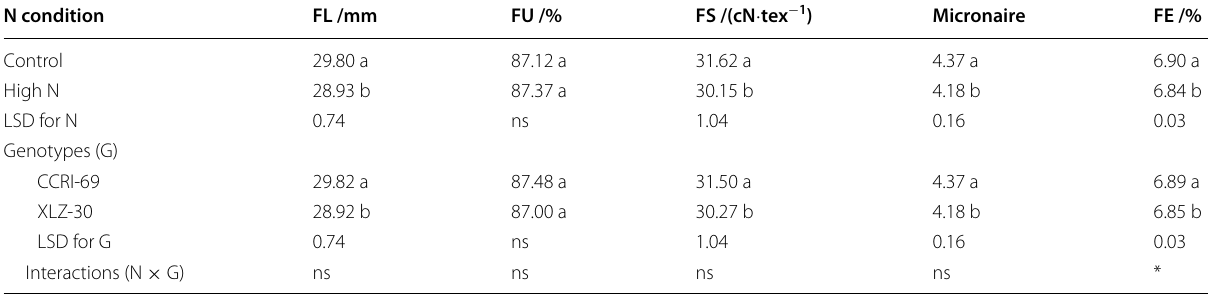
Table 2 Changes in fiber quality characteristics of contrasting N-efficient cotton genotypes under control (2.5 mmol (5 mmol L − 1 ) N conditions ·